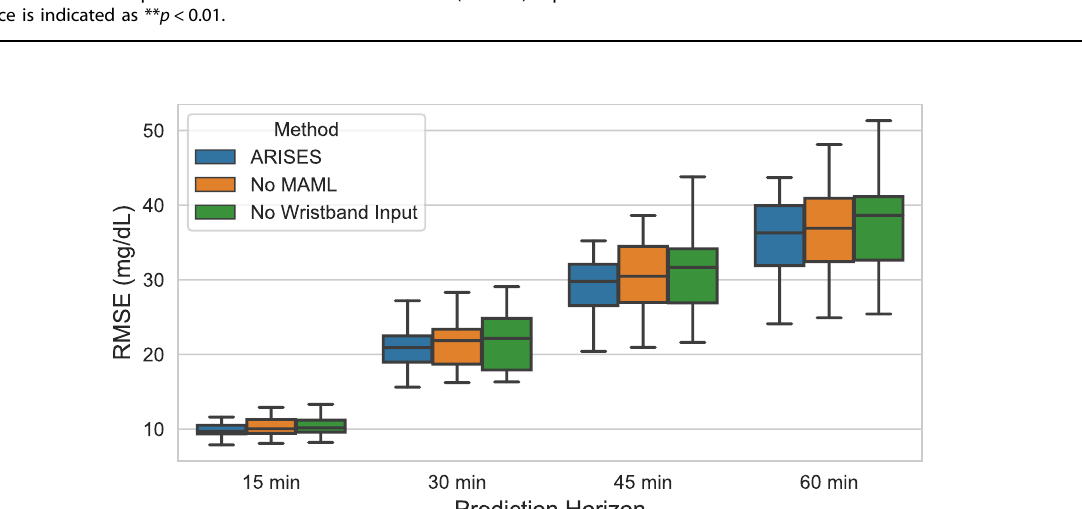
Fig. 3 Ablation analysis on the prediction performance of glucose levels. The model achieved smaller average RMSE for the 12 T1D subjects when using MAML and wristband input data. The improvement is most signi fi cant for the 60-minute prediction horizon. The lower and upper hinges of boxplots show the fi rst quarter (Q1) and the third quartile (Q3), respectively. The central lines indicate the median, while the whiskers extend to 1.5 IQR.